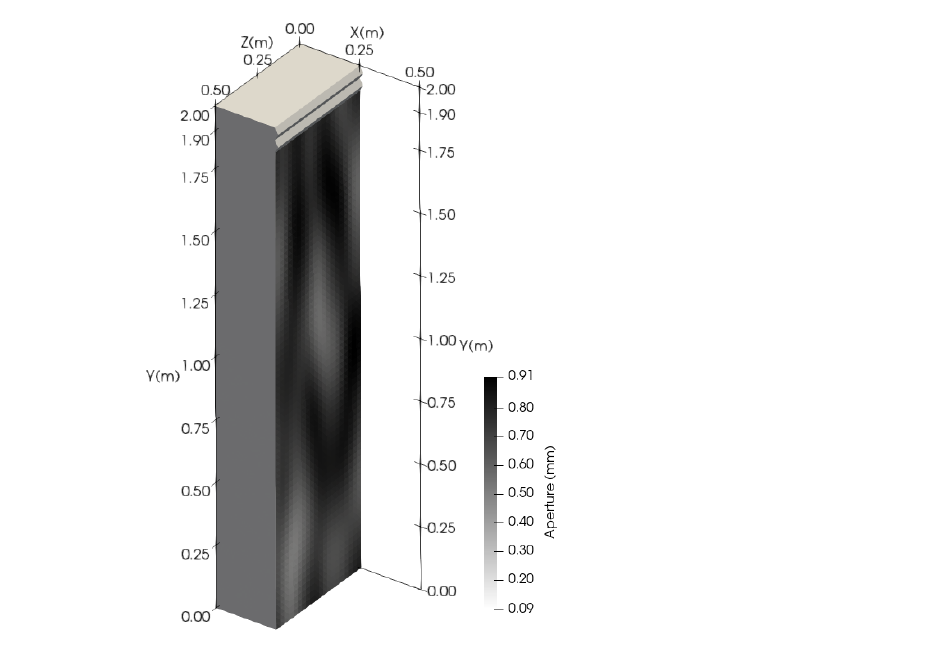
Figure 10. Fracture plane in model TUFF3D-VA with synthetically generated aperture variations between 0.09 and 0.91 mm plotted onto it.